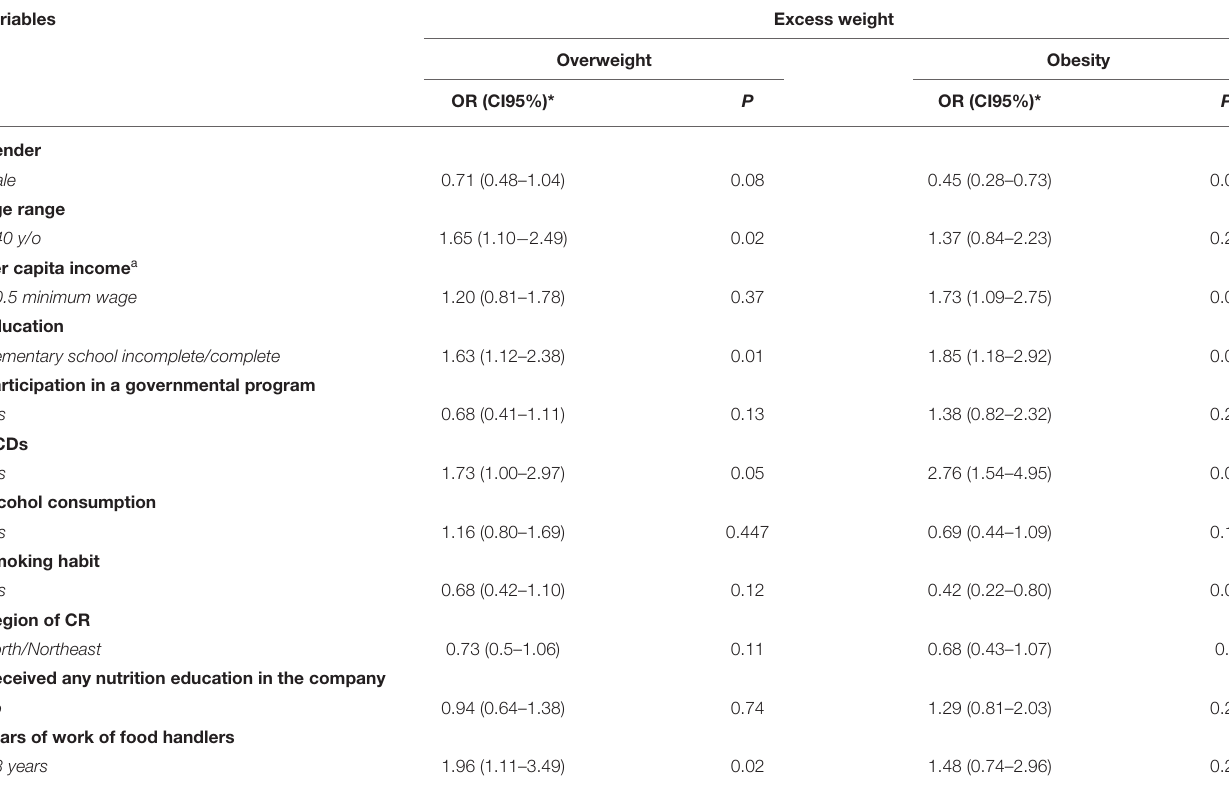
TABLE 2 | Bivariate analysis of socioeconomic, work, and health characteristics and anthropometric status according to body mass index (BMI) among food handlers in Brazilian community restaurants.